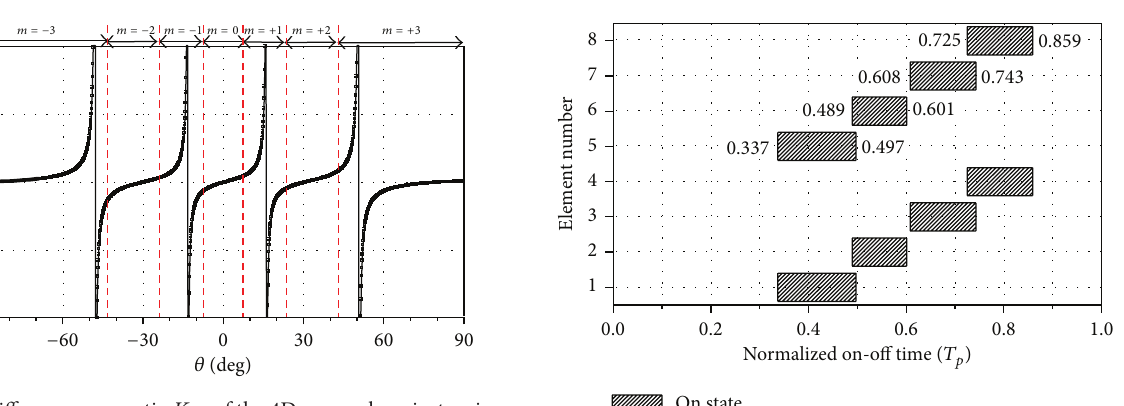
Figure 5: Difference-sum ratio 𝐾 4 elements are used. For a signal coming from the 𝑚 th sector, 𝐾 4 is used.